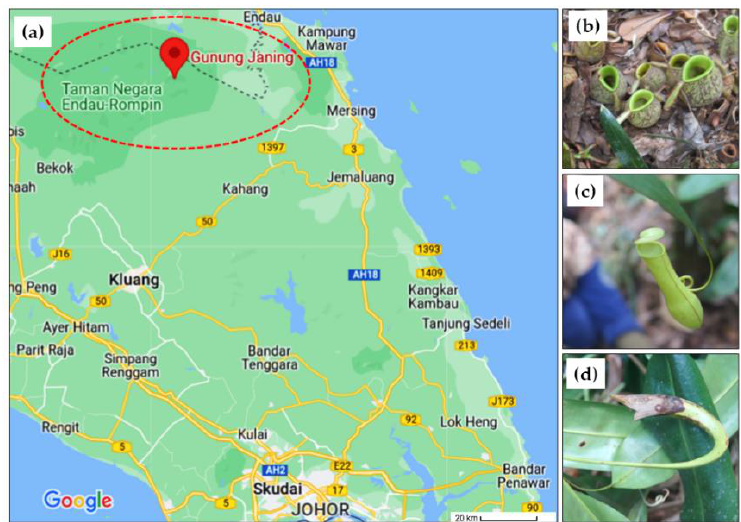
Figure 1. The geographical location ( a ) of the Nepenthes collected from Bukit Janing, Kampung Peta, Endau-Rompin National Park, Johor, Malaysia (GPS location; 2.529908870220549, 103.41185691378324). Nepenthes species collected: ( b ) Nepenthes ampullaria , ( c ) Nepenthes gracilis and ( d ) Nepenthes rafflesiana . Table 1. Polymerase Chain Reaction (PCR) profiles used in this study.